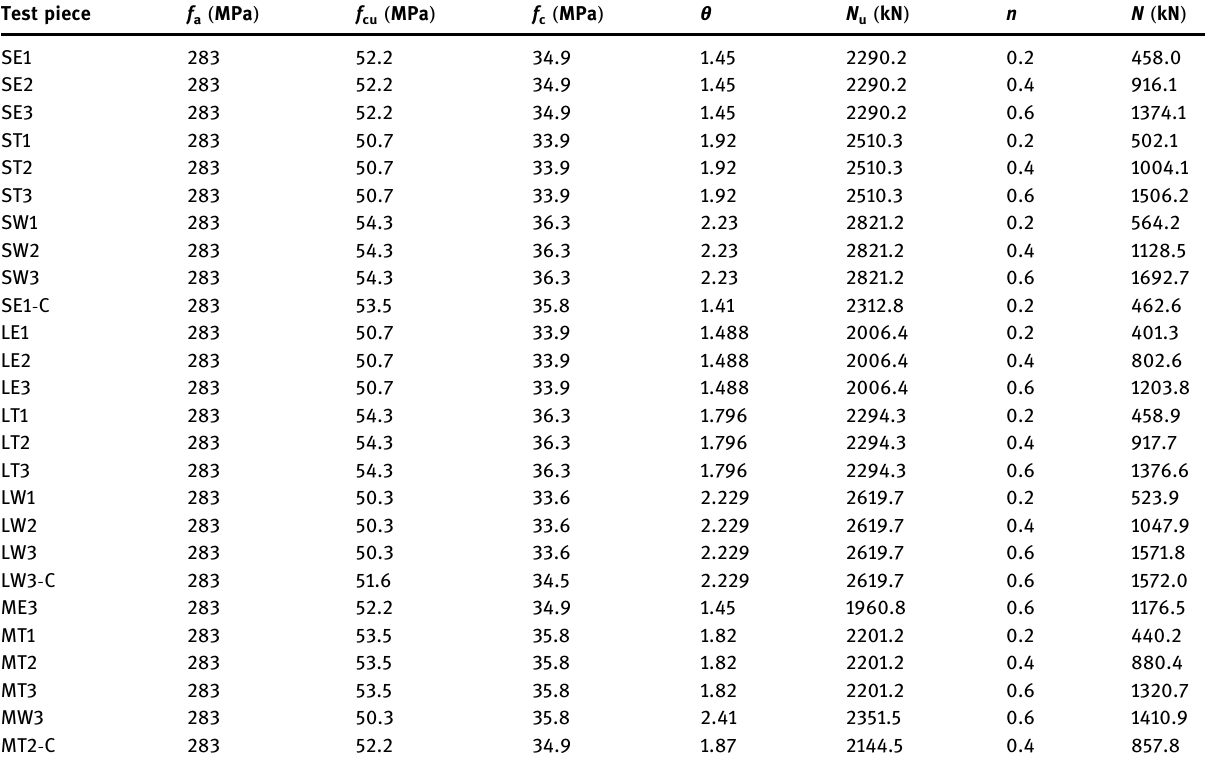
Table 8: Calculation results of axial compression bearing capacity of the test pieces Test piece